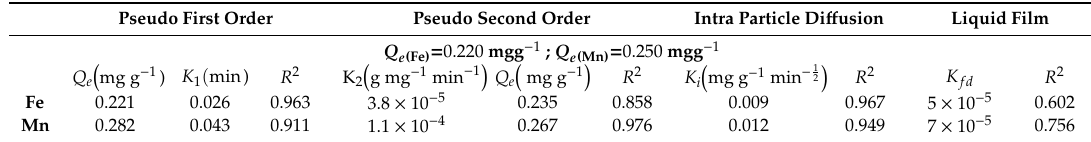
Figure 11. Pseudo second order kinetic model obtained for adsorption of iron and manganese on to zeolite Y. Initial Fe = 1.15 mg L − 1 ; Initial Mn = 1.61 mg L − 1 ; adsorbent dose = 2 g L − 1 , T = 25 °C; water pH = 6.5. Table 5. Kinetic parameters for iron and manganese onto zeolite Y.